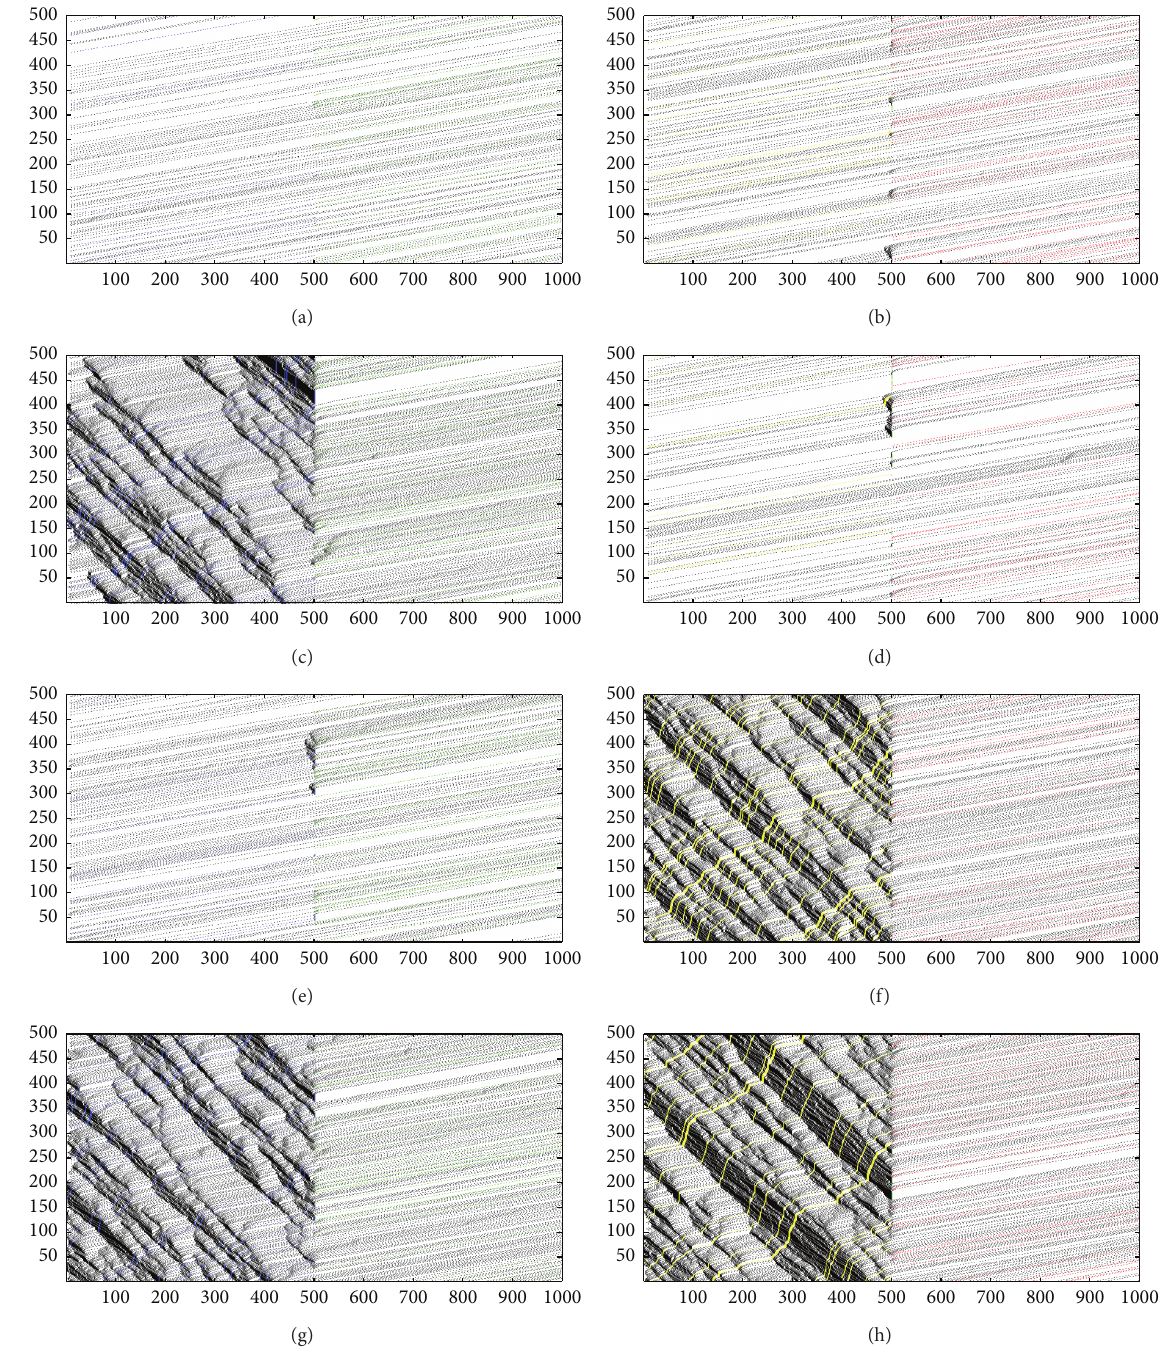
Figure 4: Spatiotemporal diagram of lane A (a), (c), (e), and (f) and lane B (b), (d), (f), and (h) with different inflow rates.